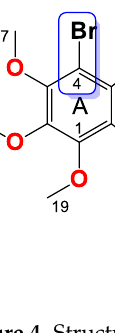
Figure 4. Structure of compound 4 .